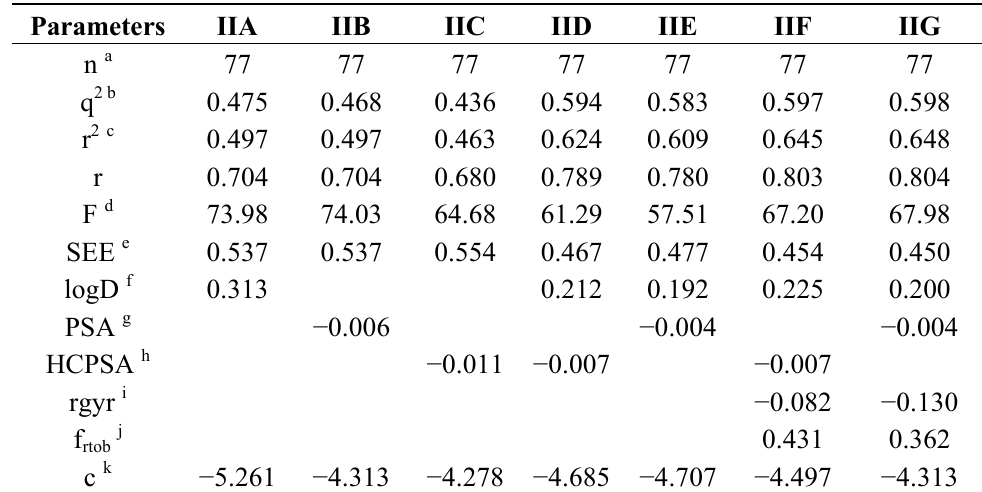
Table 4. Prediction regression model of reference data set.